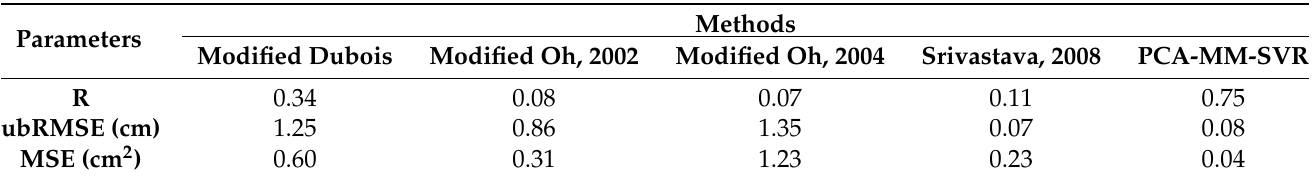
Table 5. Comparison of soil moisture estimated from SVR with the result of different backscatter and empirical regres- sion